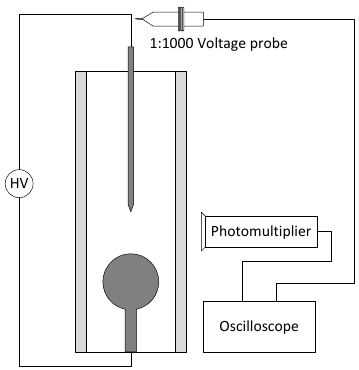
Figure 1. Experimental set up is shown. Streamers are initiated in a needle to sphere electrode configuration. A photomultiplier is used to detect the light emitted by the streamer. Both light and voltage signals are recorded with an